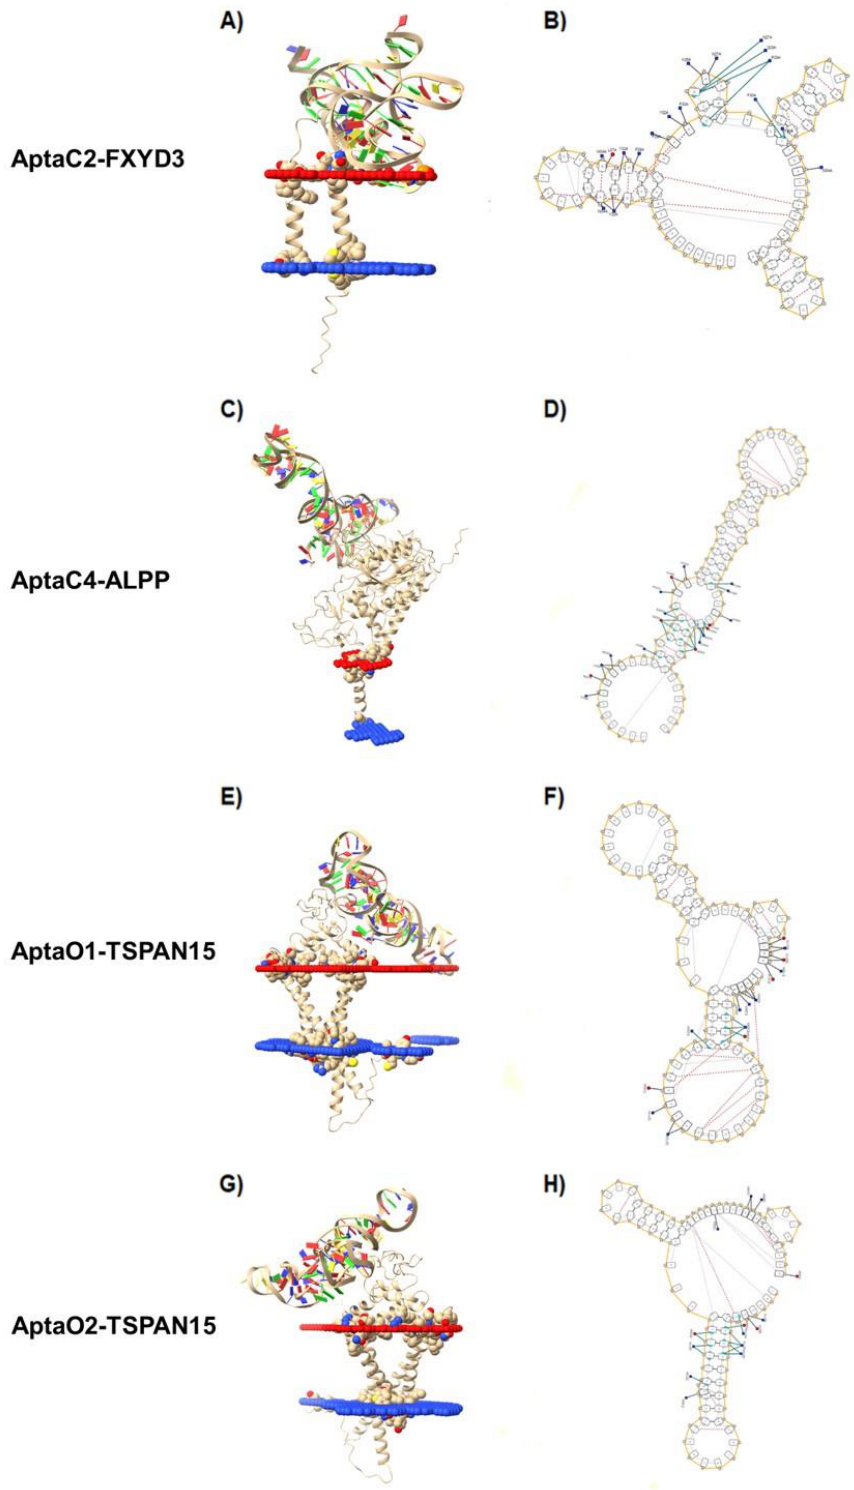
Figure 9. The best binding complexes for potential protein targets in Caov-3 and OvCar-3 cell lines. Image representing the best clusters from molecular docking for: ( A ) AptaC2-FXYD3, ( C ) AptaC4- ALPP, ( E ) AptaO1-TSPAN15, and ( G ) AptaO2-TSPAN15. Residues and interactions between the binding complexes: ( B ) AptaC2-FXYD3, ( D ) AptaC4-ALPP, ( F ) AptaO1-TSPAN15, and ( H ) AptaO2- TSPAN15.